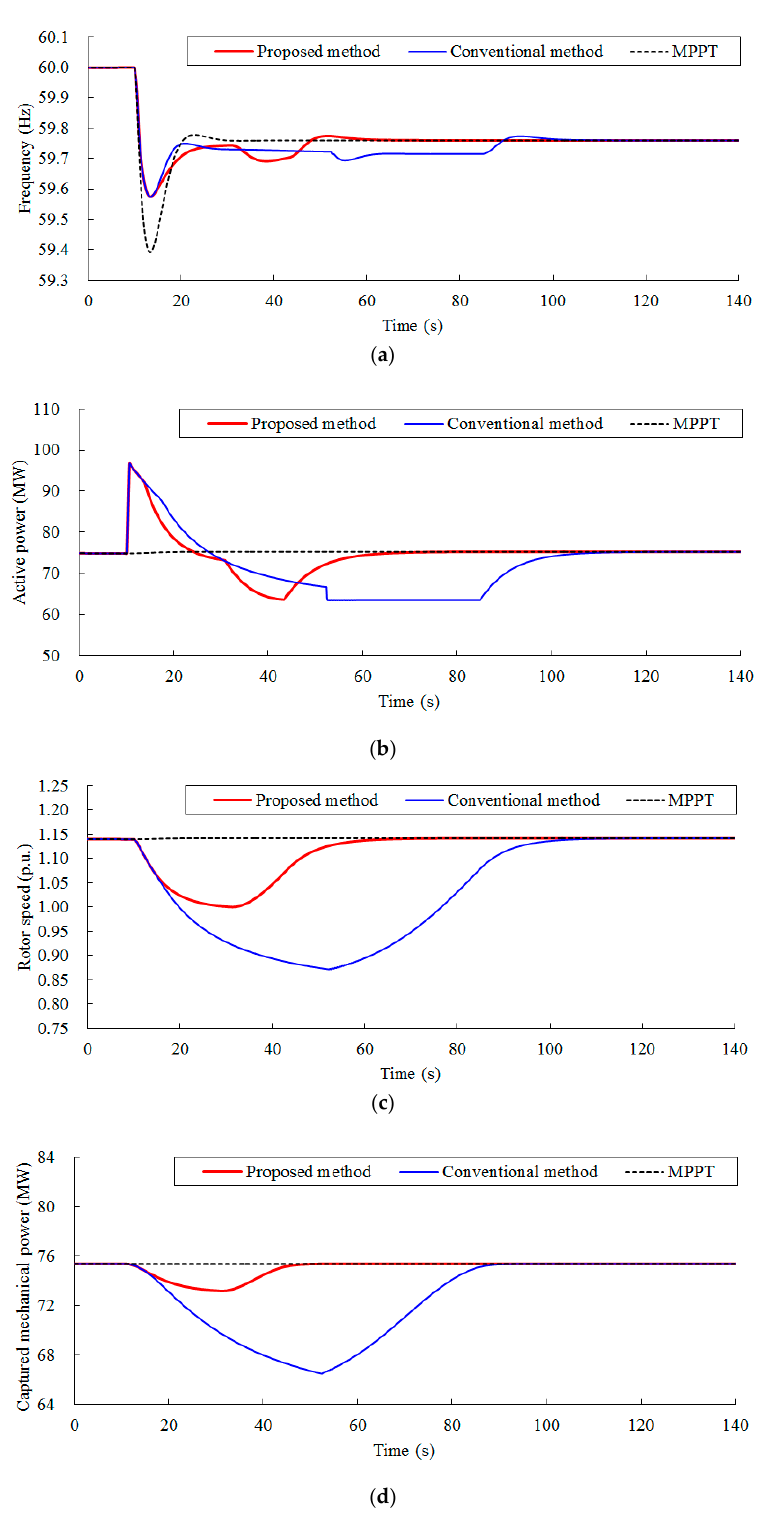
Figure 7. Results for Case 1: ( a ) system frequencies; ( b ) active powers; ( c ) rotor speeds; ( d ) captured mechanical powers.